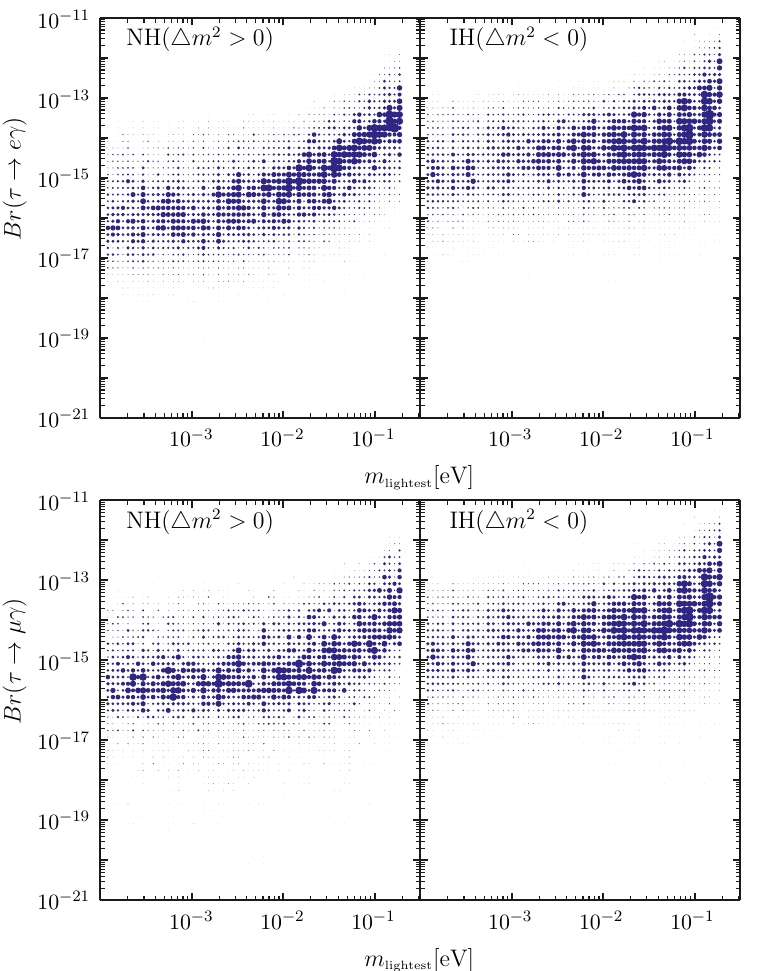
Figure 5 . Br ( τ M N = M E = M T